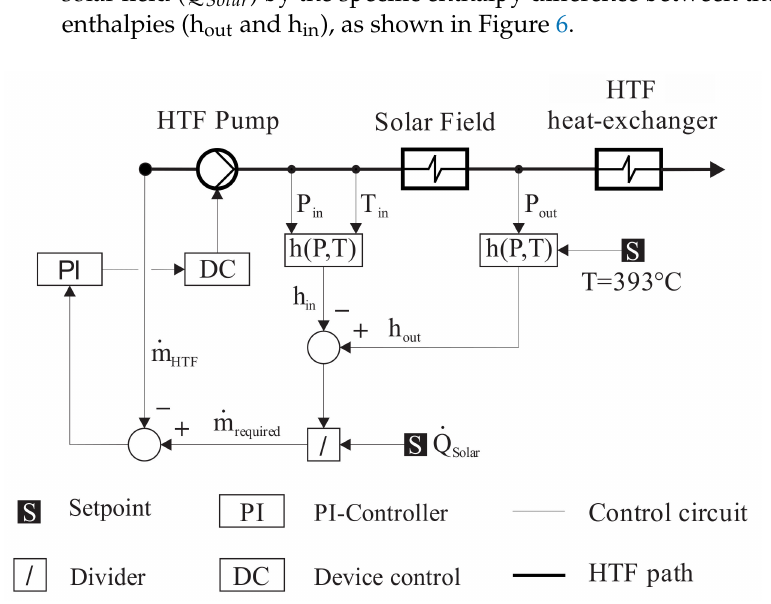
Figure 6. The HTF flow rate control